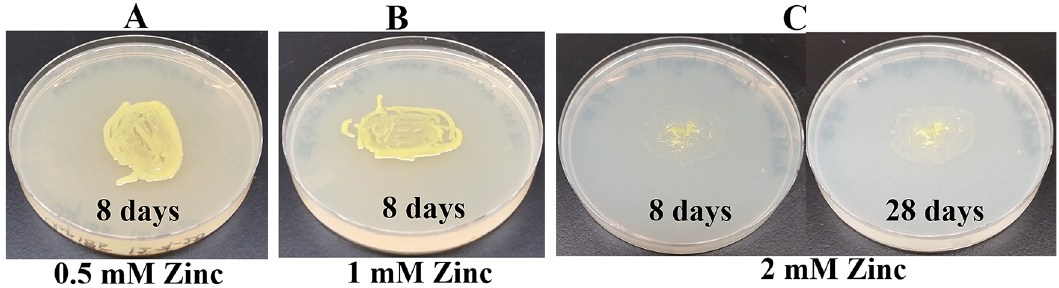
Figure 16. Growth of Clip185 on LB media containing Zinc. (A) 8 days-growth of Clip185 on LB media containing 0.5 mM Zinc. (B) 8 days-growth of Clip185 on LB media containing 1 mM Zinc. (C) 8 days (left) and 28 days (right)- growth of Clip185 on LB media containing 2 mM Zinc. Number of days of growth are labeled on the figures. Light intensity was 10-15 μ mol m -2 s -1 . Light intensity was 10-15 μ mol m -2 s -1 .